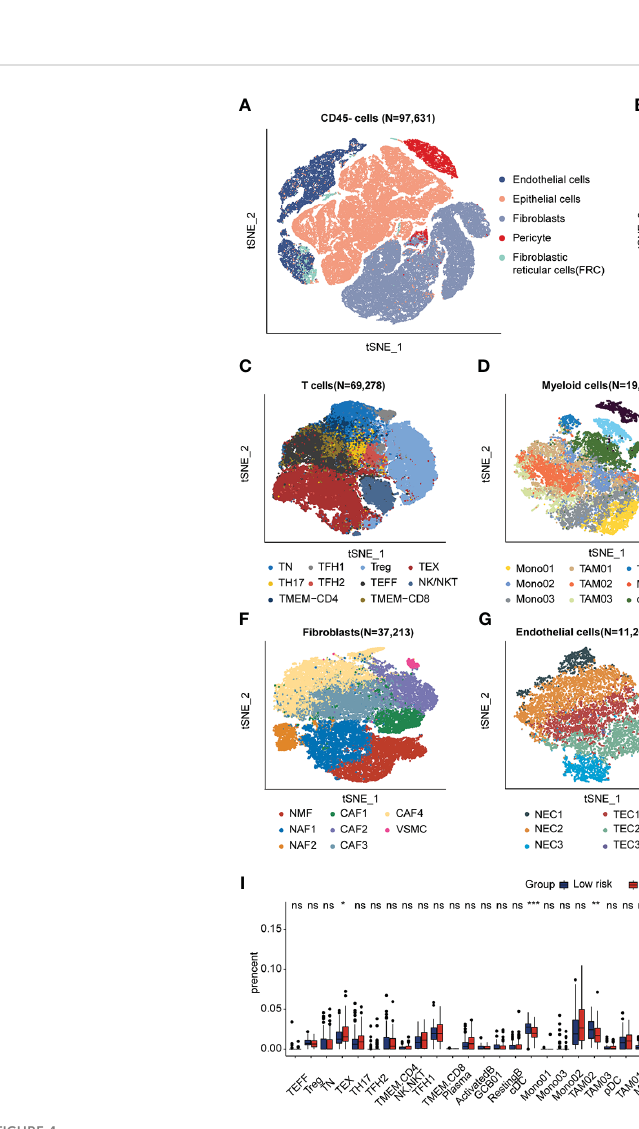
FIGURE 4 Visualization plots of scRNA-seq data. (A, B) tSNE plot of 208,659 cells from ESCC. (C – G) tSNE plots of T cells, Myeloid cells, B cells, Fibroblasts and Endothelial cells colored by cell type. (H) Fractions of each cell type in low- and high-SIRGs score group. (I) The different TME cells in low- and high-IRRS score groups. * p <0.05, ** p <0.01, *** p <0.001, ns, not signi fi